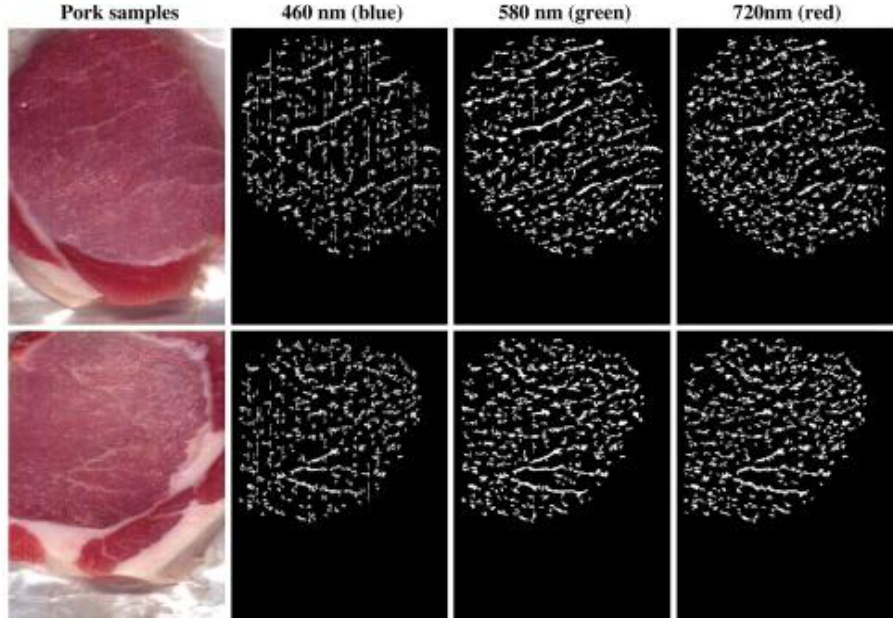
Figure 7. Wide line detector for extracting line feature from red, green, and blue images of